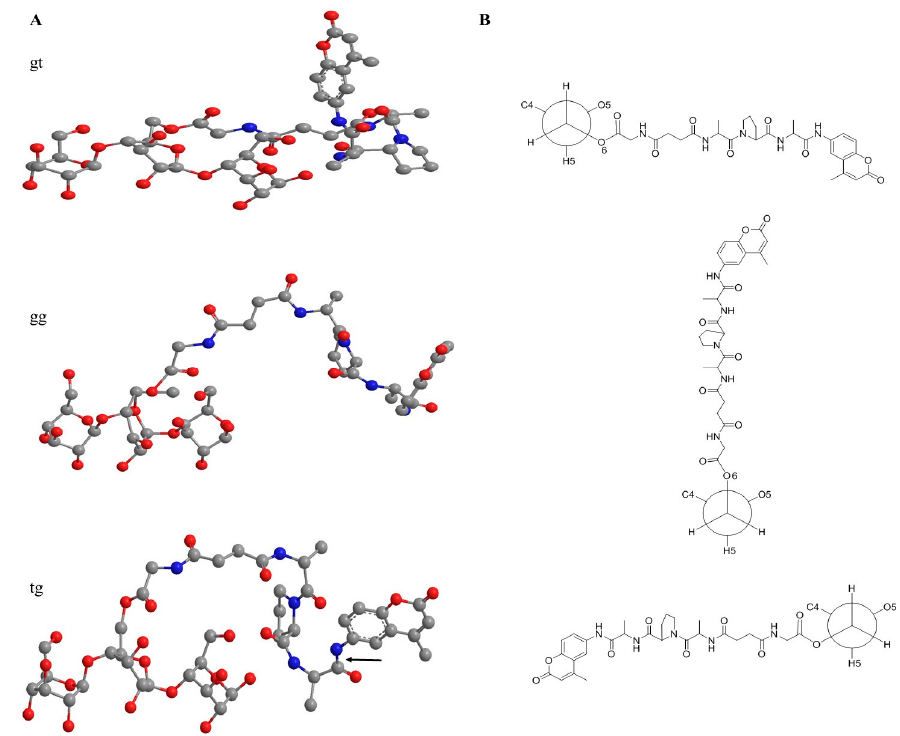
Figure 7. The conformational structures of the tripeptide substrate anchored onto a cellotriose unit at the hydroxymethyl gt O6 rotamer, gg O6 rotamer, and tg O6 rotamer orientation of the cellulose or nanocellulose sensors in: ( A ) minimized model; or ( B ) Newman projections. The black arrow shown for the tg O6 rotamer shows where the HNE protease cleaves the fluorophore. Note: gray is carbon, blue is nitrogen, red is oxygen. Table 3. Distance of AMC (7-amino-4-methylcoumarin) tripeptide substrate from the five-chain 110 or 1–10 surface of the cellulose floor.